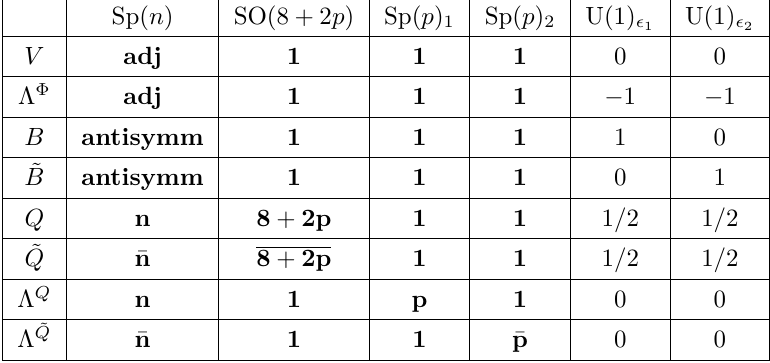
Table 1. The N = (0 , 2) multiplets and symmetries on worldsheet in 6d SO(8 + 2 p ) gauge theory.